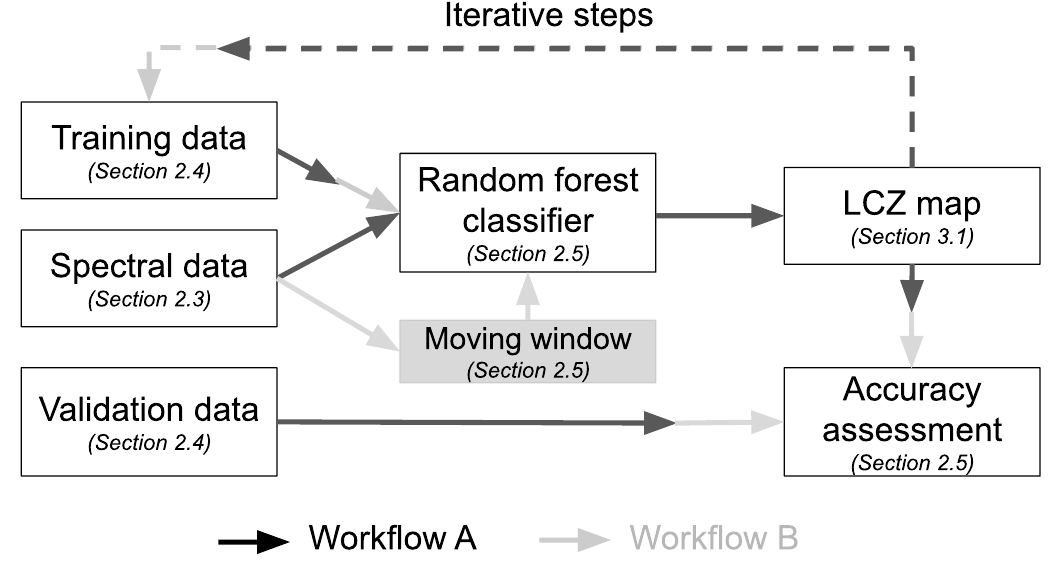
Figure 4. Overview of LCZ classification. Workflow A is default World Urban Database and Access Portal Tool (WUDAPT) protocol, while Workflow B is the modified workflow that uses a moving window to include neighbourhood information. Redesigned after Figure 3 in Reference